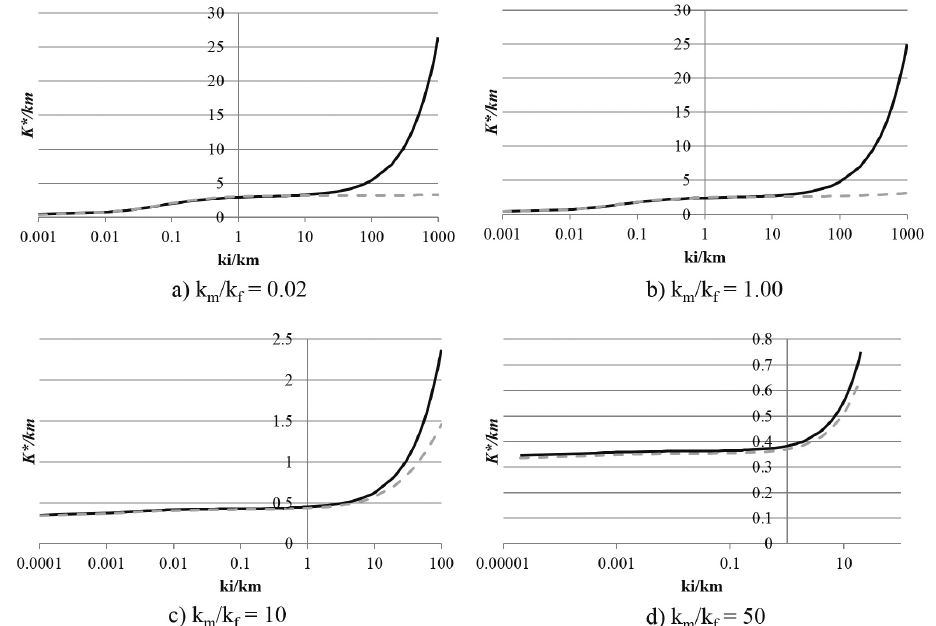
Figure 12. Effective thermal conductivity versus interphase thermal conductivity for imperfect/perfect interfaces and v lines - imperfect interfaces; dashed lines - perfect